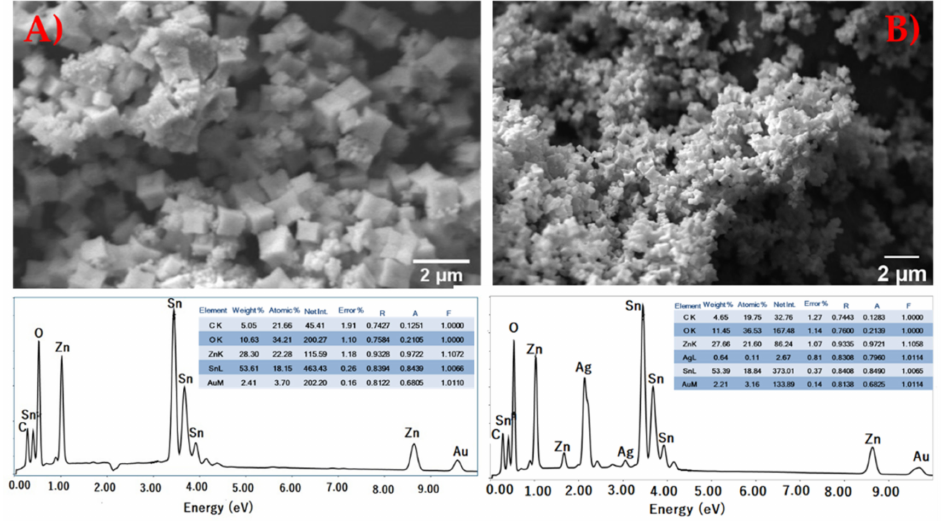
Figure 5. SEM images of ( A ) ZnSnO 3 and ( B ) Ag-ZnSnO 3 samples and their respective EDS